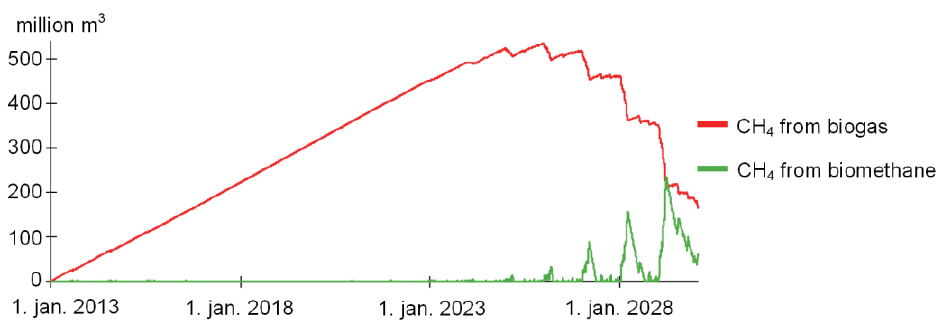
Fig. 10. The amount of accumulated CH 4 from biogas and CH 4 from biomethane for the second